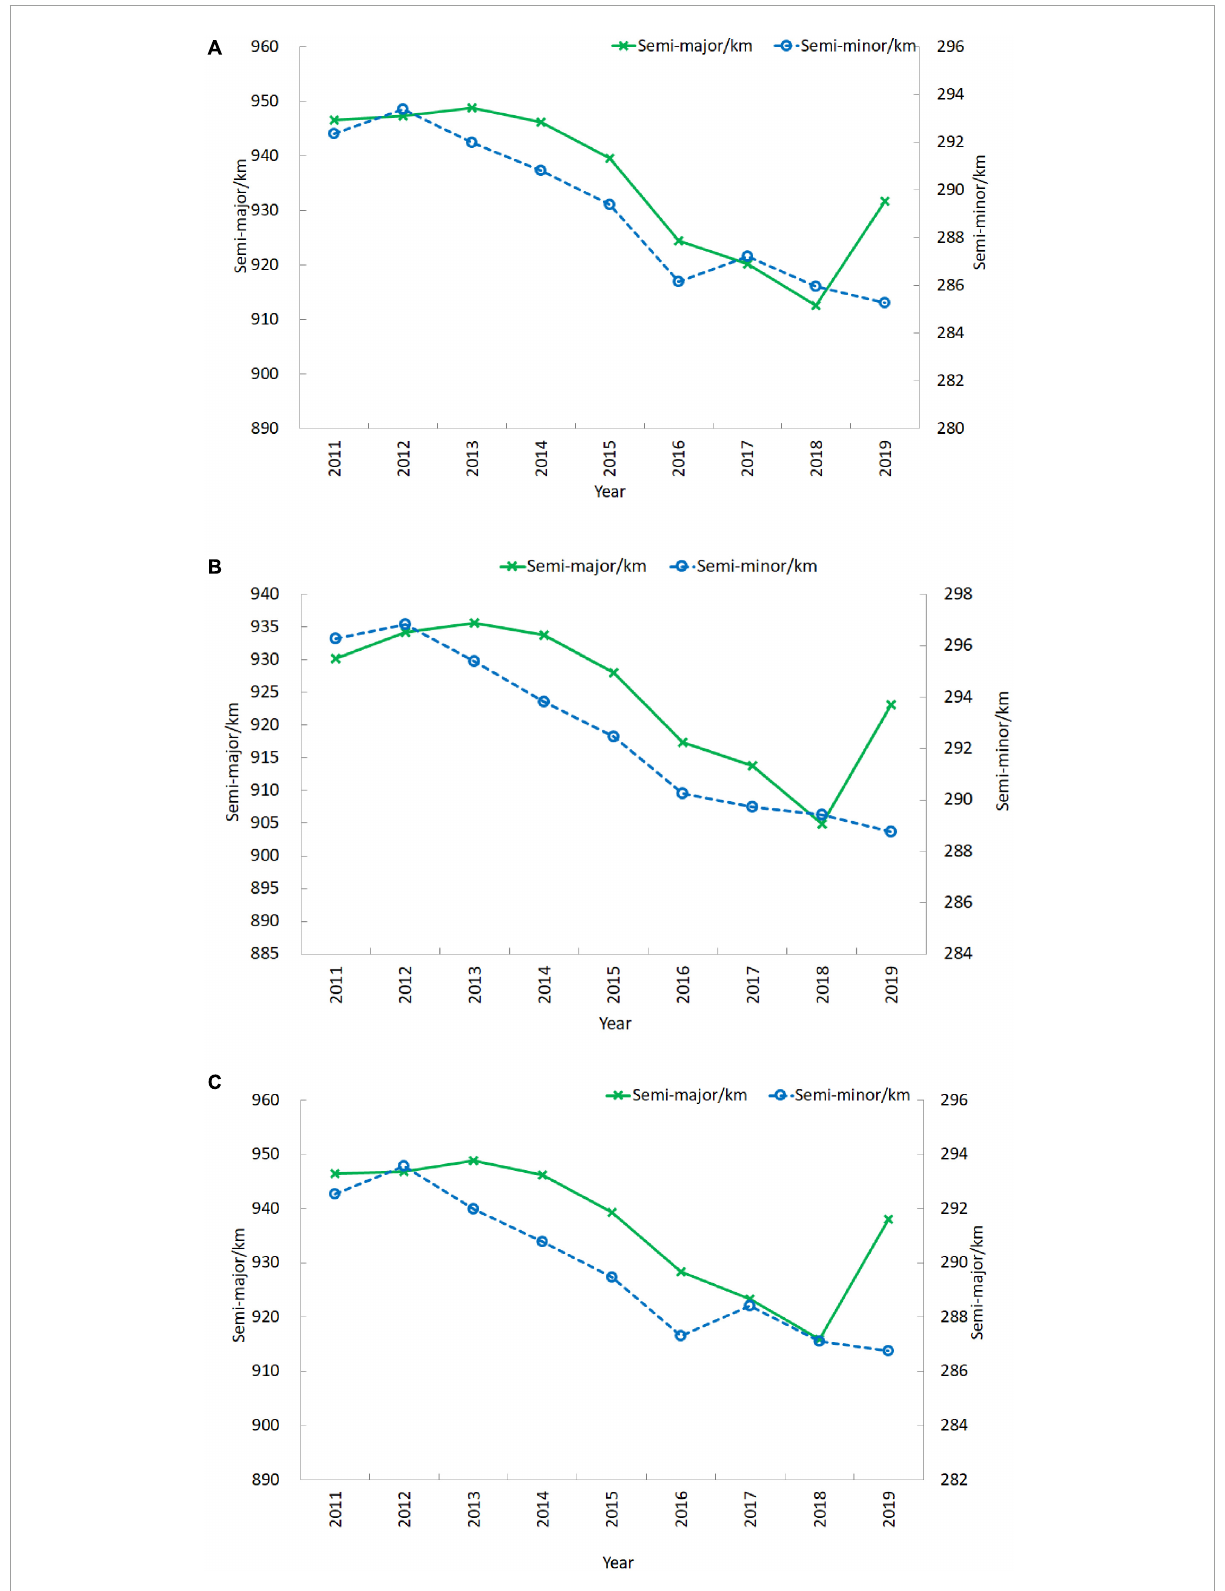
FIGURE4 Variation of semi-major and semi-minor axes of subsystems’ standard deviational ellipse. (A) Water. (B) Energy. (C) Food.